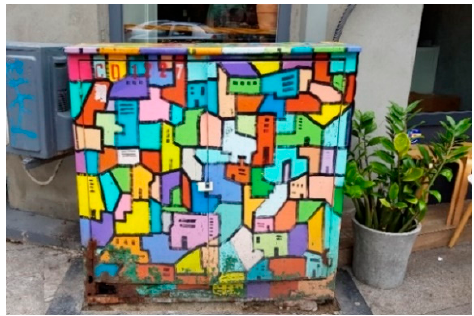
Figure 34. Mihail Kog ă lniceanu Square, Bucharest, no data (photo taken in 2022).